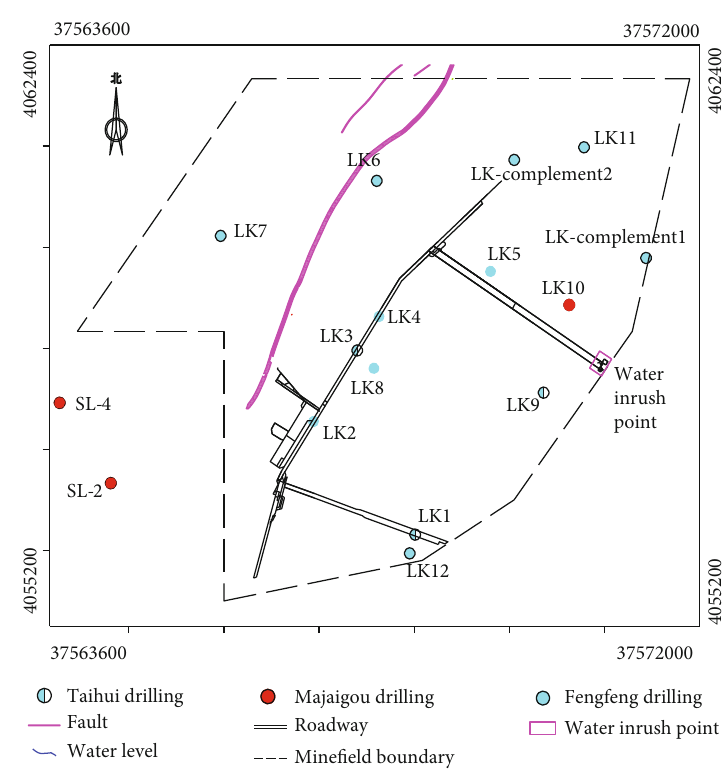
Figure 4: Layout of observation holes.